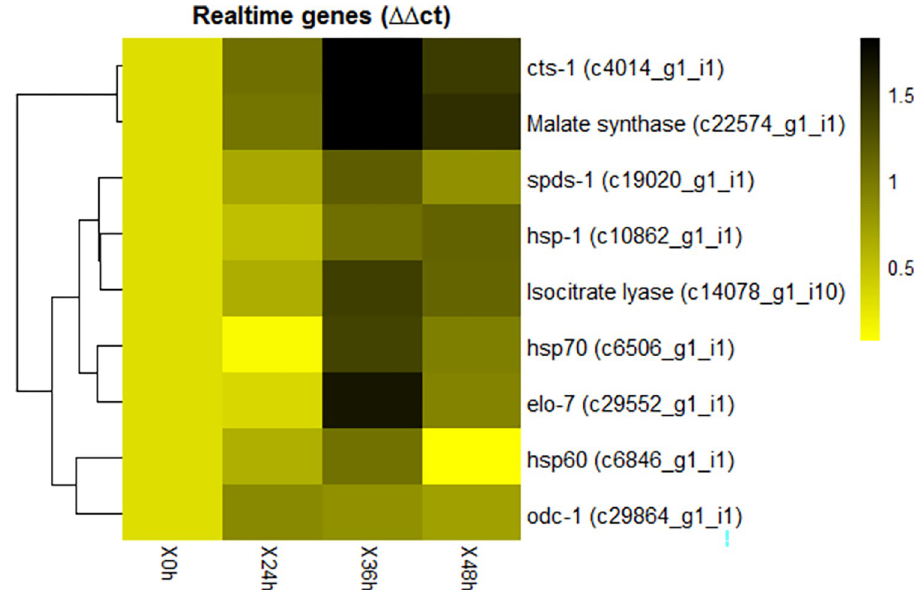
Fig 9. Temporal expression pattern of genes during induction of anhydrobiosis in H . indica validated using qRT-PCR.